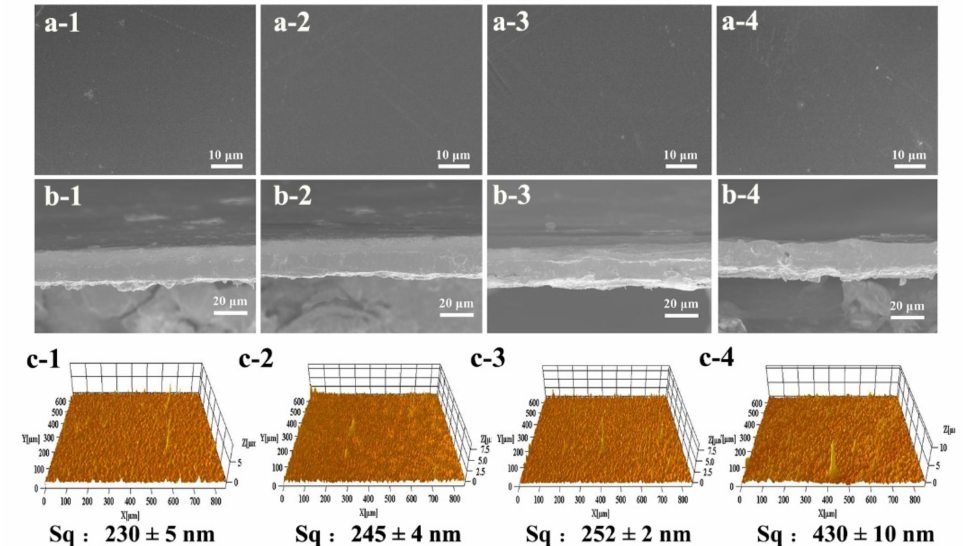
Figure 4. Characterization of surface morphology and roughness of PVB-X% TPAPS coatings. The SEM images of surface ( a , b ) section morphology, ( c ) typical three-dimensional contour height images of the coating surfaces for (1) PVB, (2) PVB-10% TPAPS, (3) PVB-20% TPAPS, (4) PVB-30% TPAPS and their corresponding roughness,